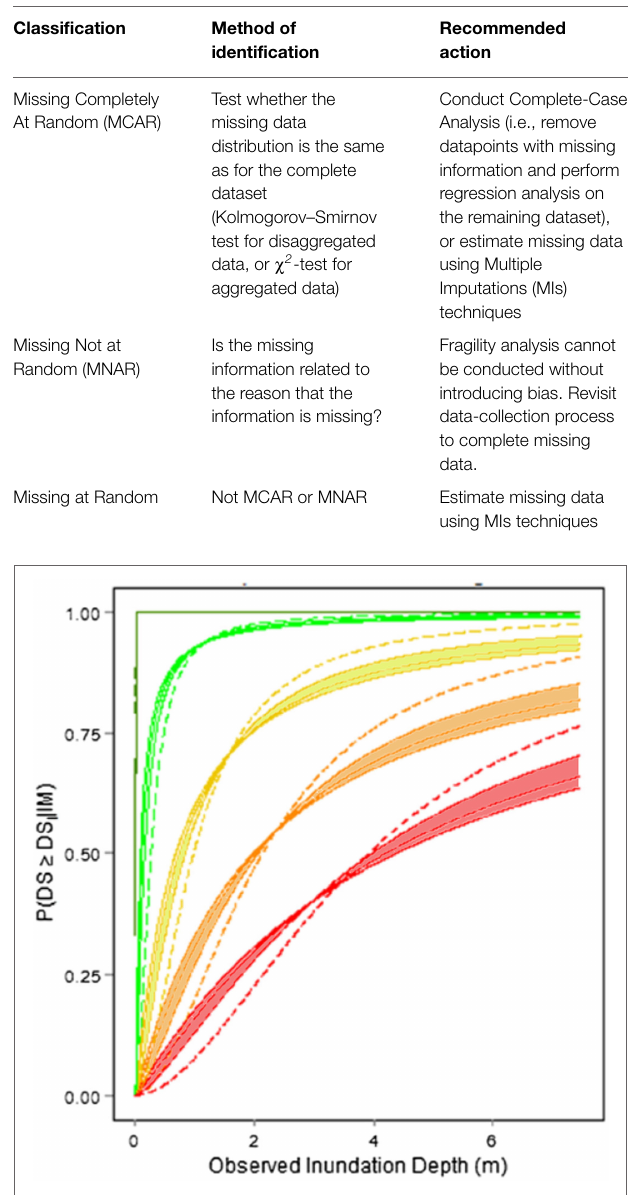
FIGURE 6 | The effect of ignoring incomplete datasets. Dashed-lines show curves formed using complete-case analysis for steel and RC buildings from the 2011 Japan Tsunami (i.e., ignoring all buildings for which the construction material was unknown). Solid lines show a range of mean curves for the imputed dataset (i.e., with building material for “unknown” buildings estimated using MI). Colours indicate the individual damage states, from light damage (dark green) to collapse (red). (Adapted from Macabuag et al.,